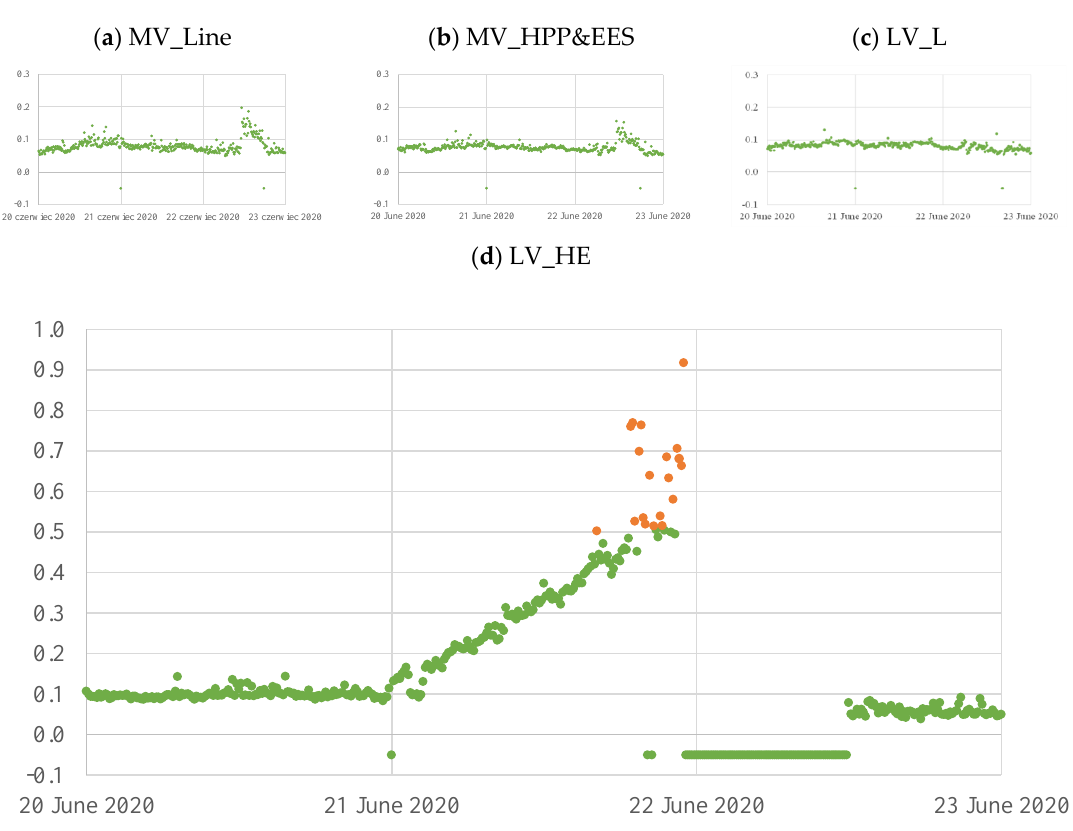
Figure 6. Specific working conditions observed in the level of ADI for measurement point ( a ) MV_Line, ( b ) MV_HPP&EES, ( c ) LV_L, ( d ) LV-HE.